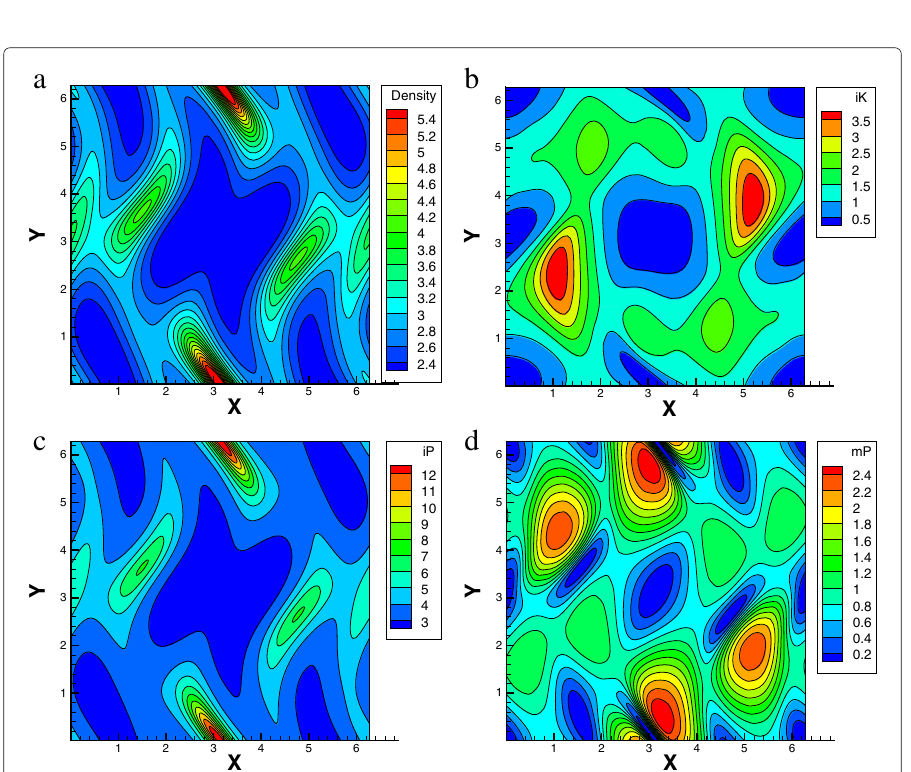
Fig. 14 The UGKWP results of the multiscale Orszag-Tang vortex problem with